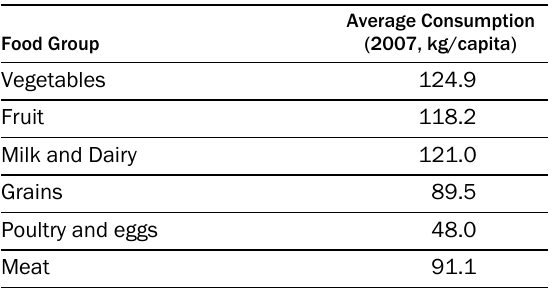
Table 4. Food Availability by Food